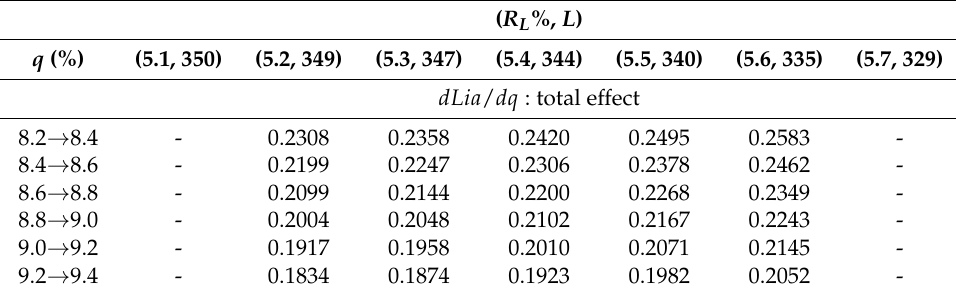
Table 8. Responsiveness of the bank’s liabilities to capital-to-deposits ratio 1 .